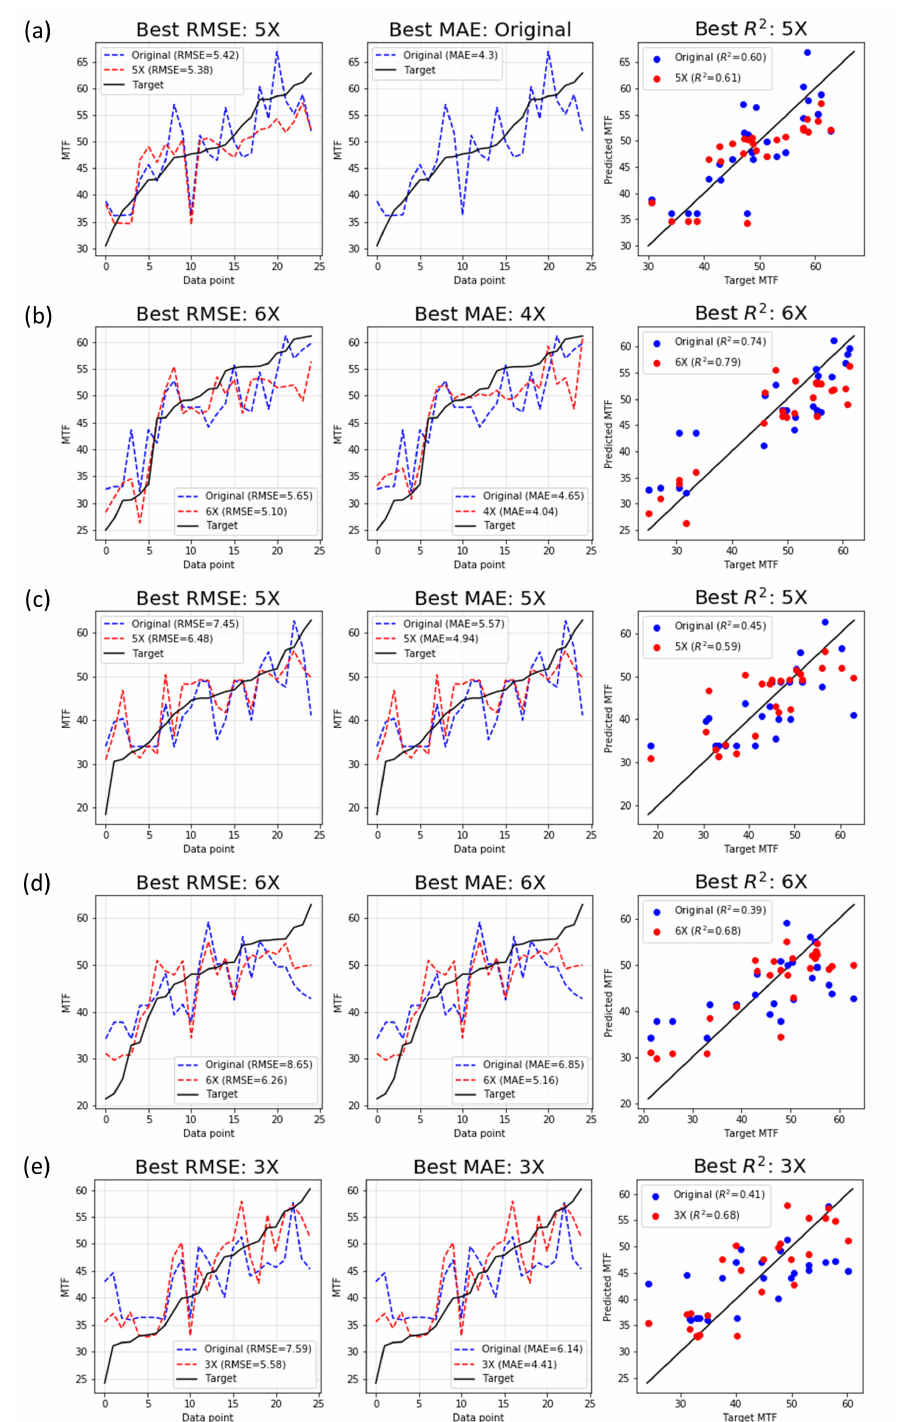
Figure 5. Regression results of 5 test sets on RMSE, MAE and R 2 ; ( a ) Val 1 ( b ) Val 2 ( c ) Val 3 ( d ) Val 4 ( e ) Val